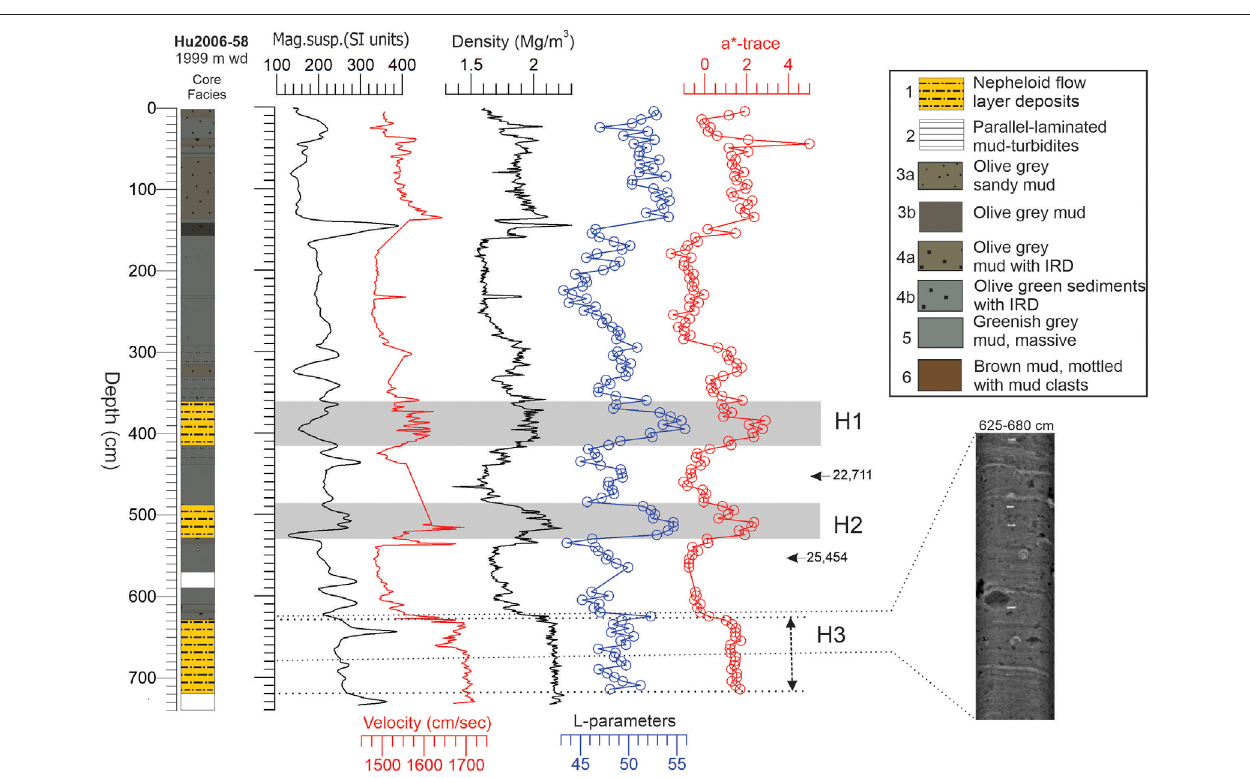
FIGURE 4 | Magnetic susceptibility, P-wave velocity, and density of the bulk sediments, L* and a*-traces, X-radiographs, and core photographs were used to assign sediment facies of core Hu2006040-58. H1 and H2 layers are identi fi ed between 362 and 415 cm and 482 and 526 cm by two 14 C-AMS dates. The interval between 630 and 715 cm is most likely the H3 layer. A representative X-radiograph of the H3 layer between 625 and 680 cm demonstrates the waning in fl uence of sediment plume, ~1,000 km distance from the Hudson Strait ice stream at site 58.